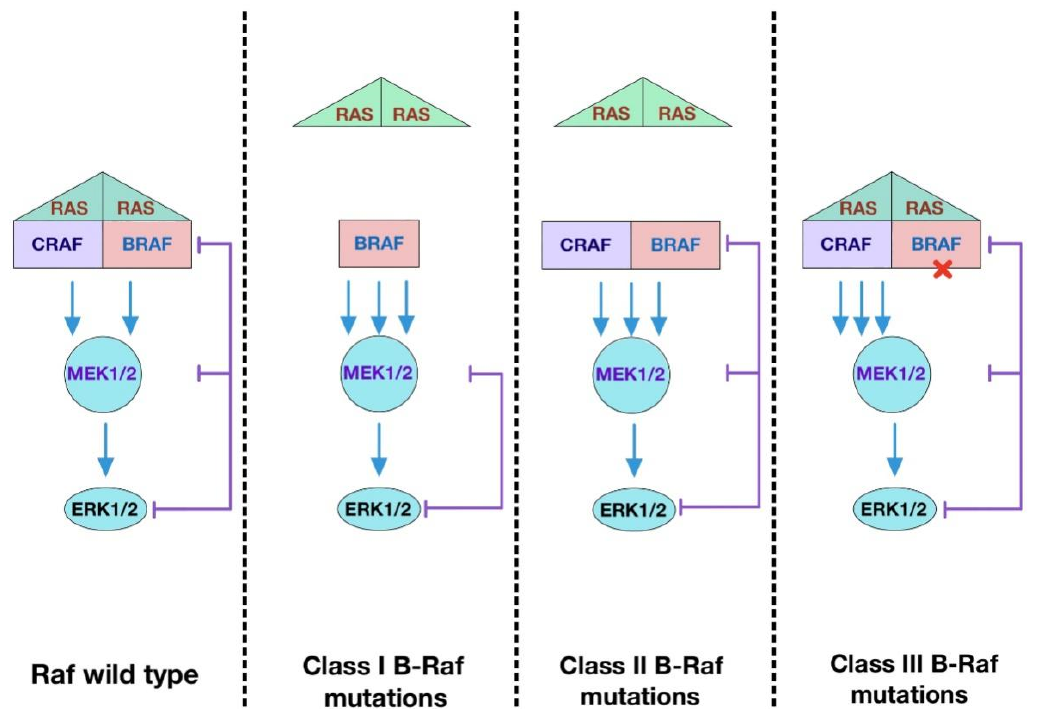
Figure 3. Functional classes of B-Raf mutations. Class I B-Raf mutants contain V600E/D mutations in the activation loop which can signal as active monomers, independent of Ras. Class II B-Raf mutants are Ras-independent and signal as dimers. Class III B-Raf mutants have reduced kinase activity and drive the activation of ERK signaling by transactivating wild-type Raf which signals as mutant B-Raf–wild-type C-Raf dimers. These mutants require active Ras to trigger a signaling